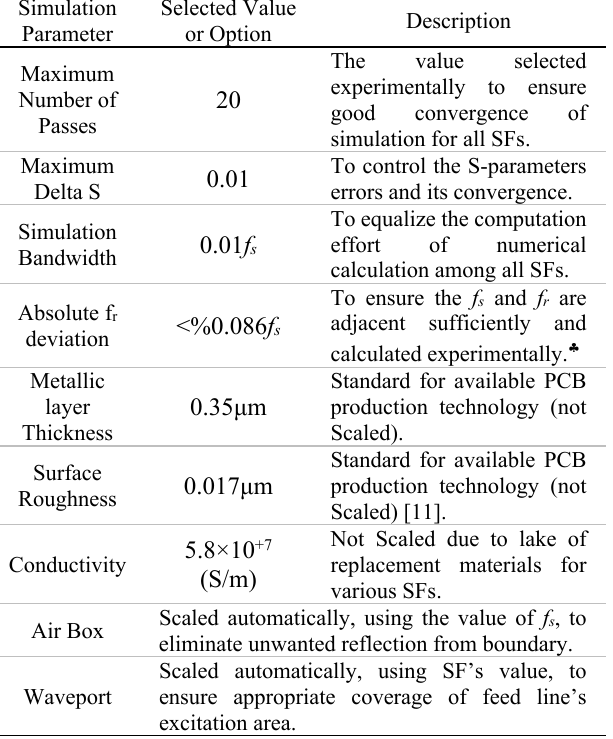
Figure. 1. Configuration and dimensions of the microstrip antenna. All the dimensions are in millimeters. Table 1: The investigated system specifications in simulation